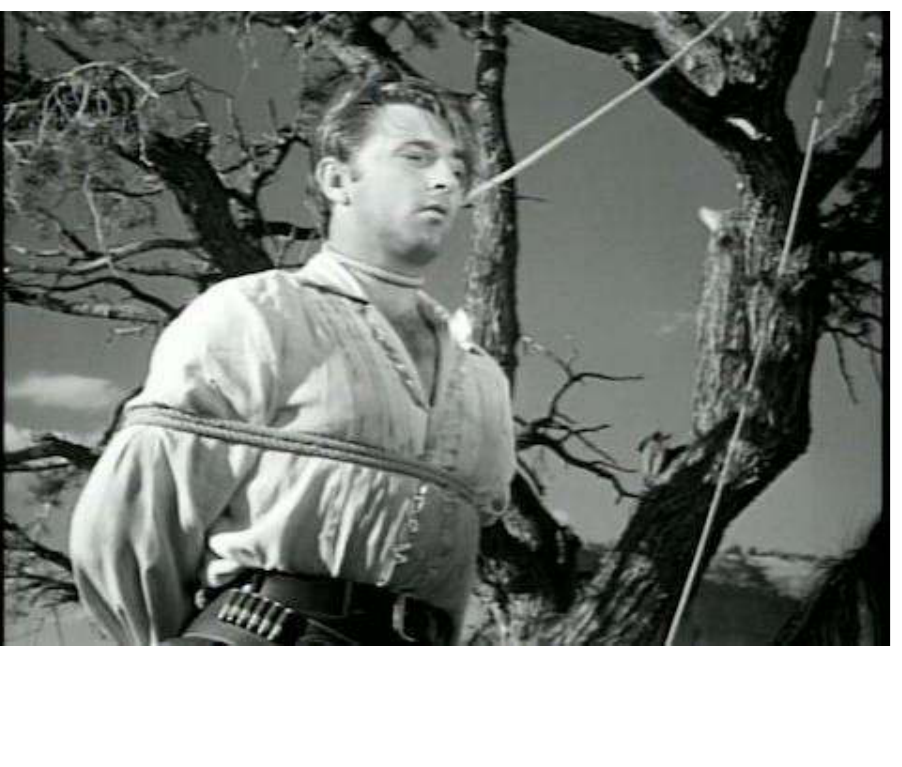
Figure 7: The attempted lynching of Jeb in Pursued